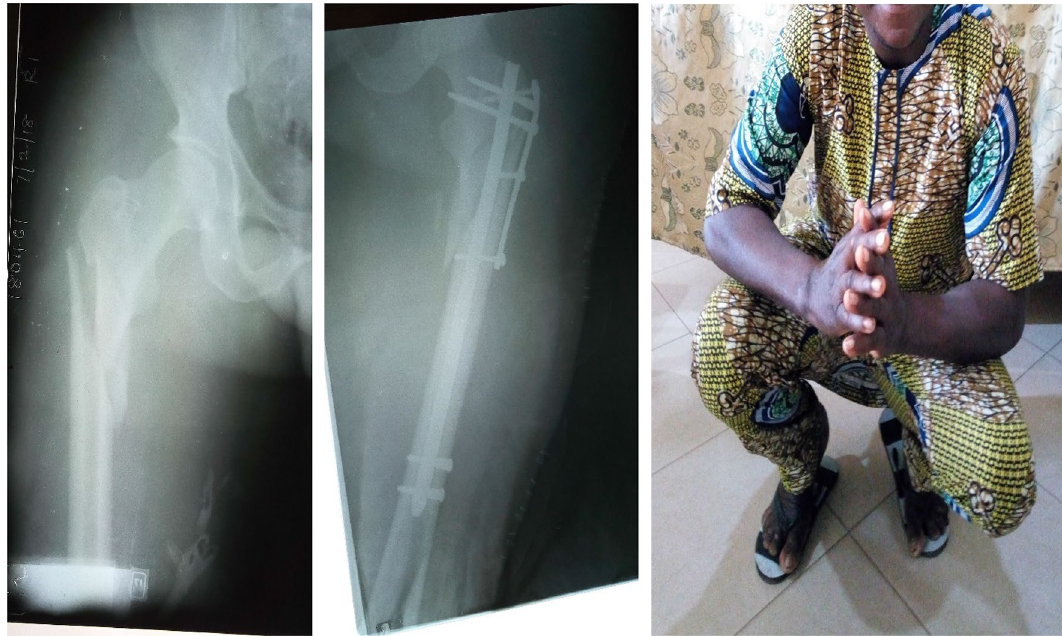
Figure 5. Pre- and post-operative radiographs and “squat and smile” photograph (6-week follow-up) of a 33-year old man who had the SIGN nail combined with the SIGN HV plate to treat a reverse oblique femur fracture with diaphyseal